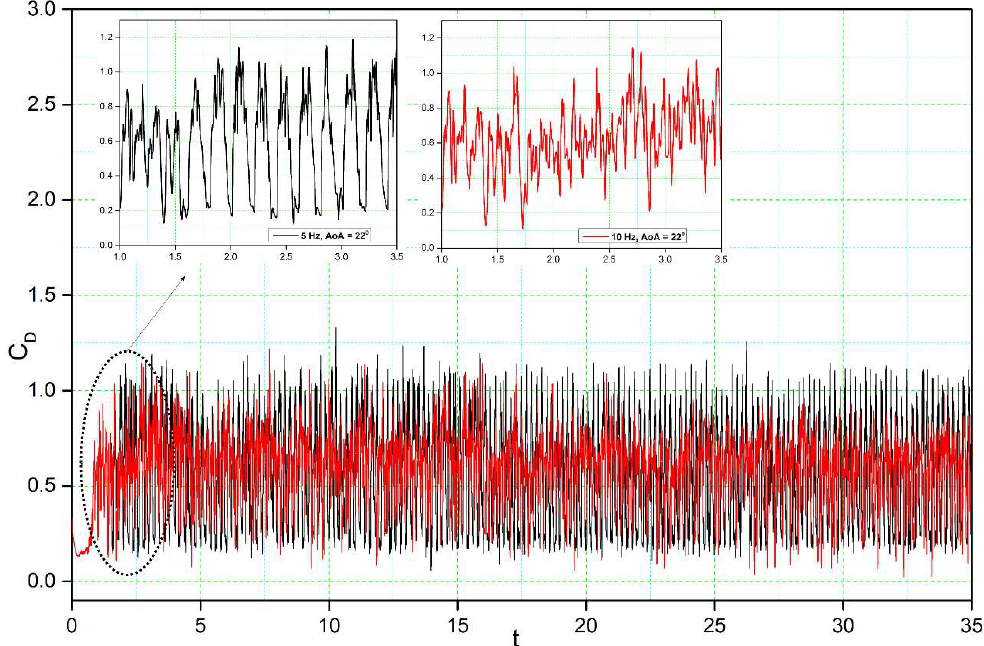
Figure 18. Drag coefficient transient responses for DMLE airfoil at 5 Hz and 10 Hz.